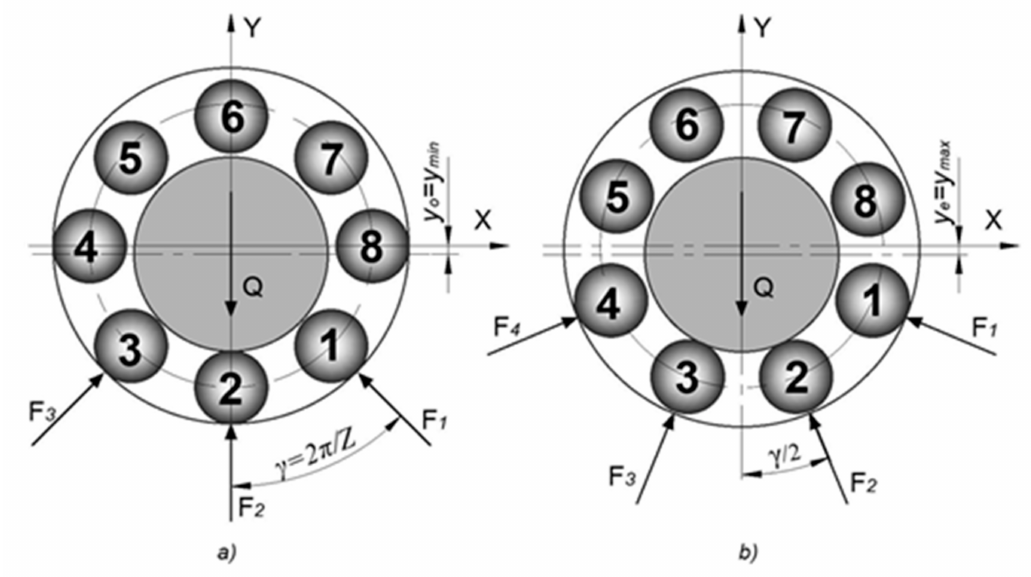
Figure 1. Boundary positions of inner rings support, ( a ) BSO position, ( b ) BSE